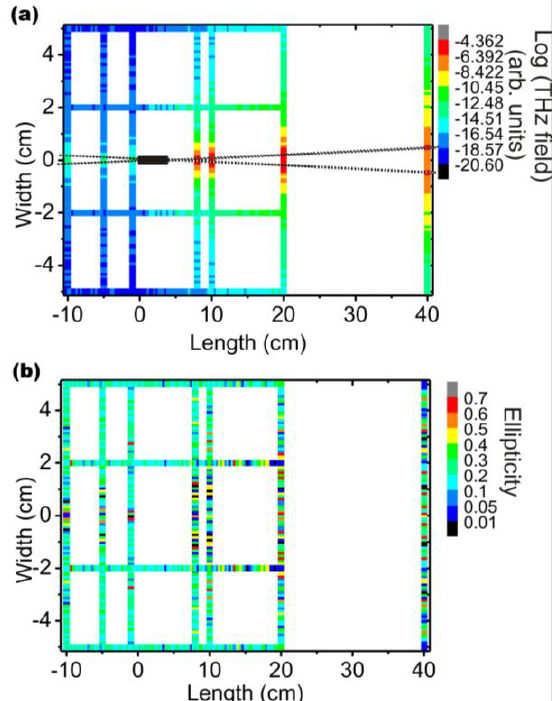
Fig. 2 Spatial distribution of the THz field strengths (a) and ellipticities (b) calculated for ν=29 THz for l=6 cm and σ=0.1 cm. The black rectangle is the emitted medium. The typical THz field distributions calculated for l=6 cm, σ=0.1 cm, θ=π/4 and ν=29 THz are